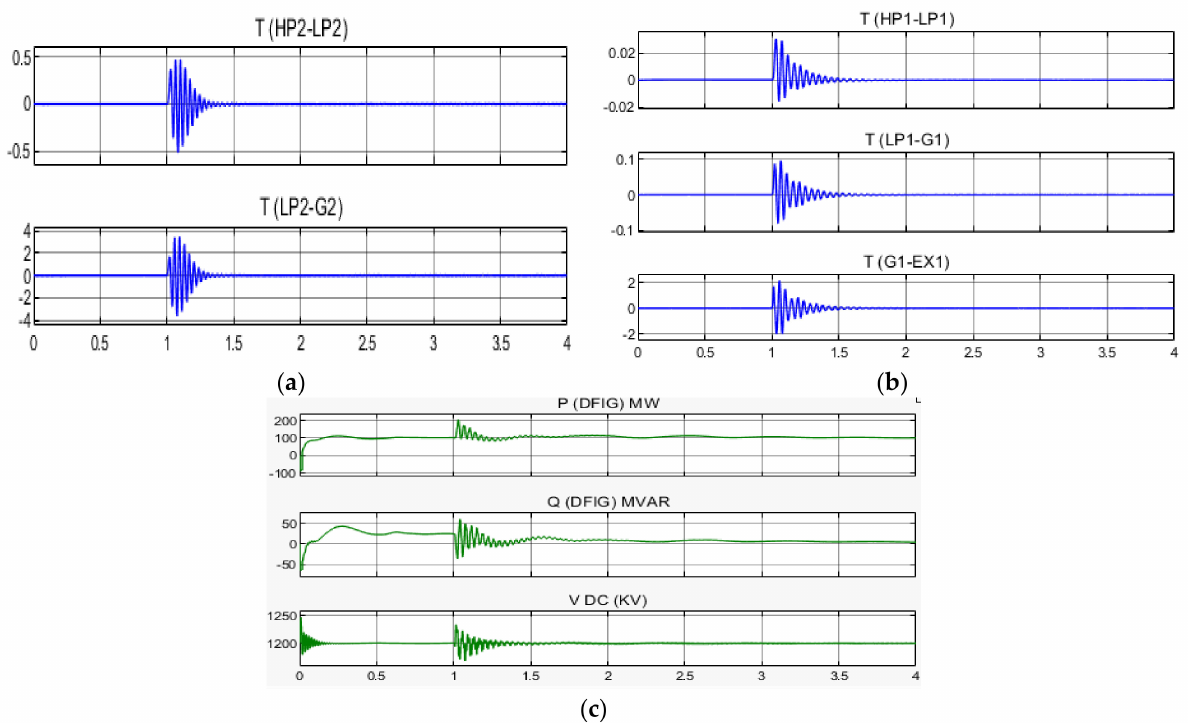
Figure 9. Damping of SSR oscillation in synchronous generation and DFIG with wide-area fuzzy controller without time delay. ( a ): turbine torque of second synchronous generation, ( b ): turbine torque of first synchronous generation, ( c ): V DC , Q, and P of DFIG.